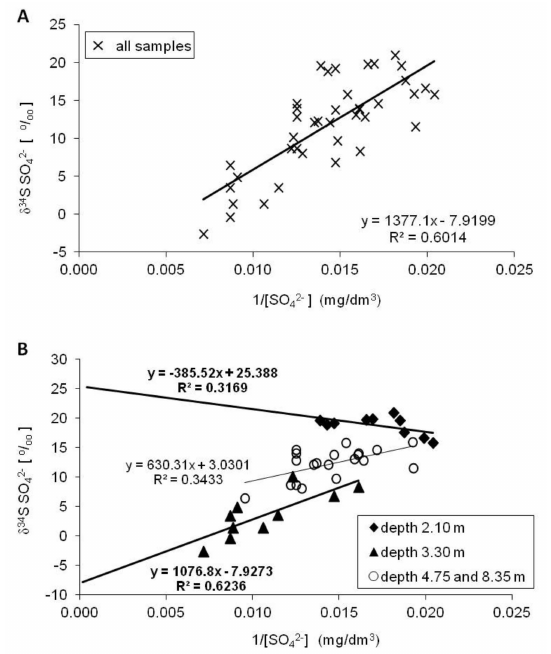
Figure 5. The δ 34 S values and concentrations of dissolved sulfates in groundwater profile of the Po˙zary aquifer. For more explanations see the